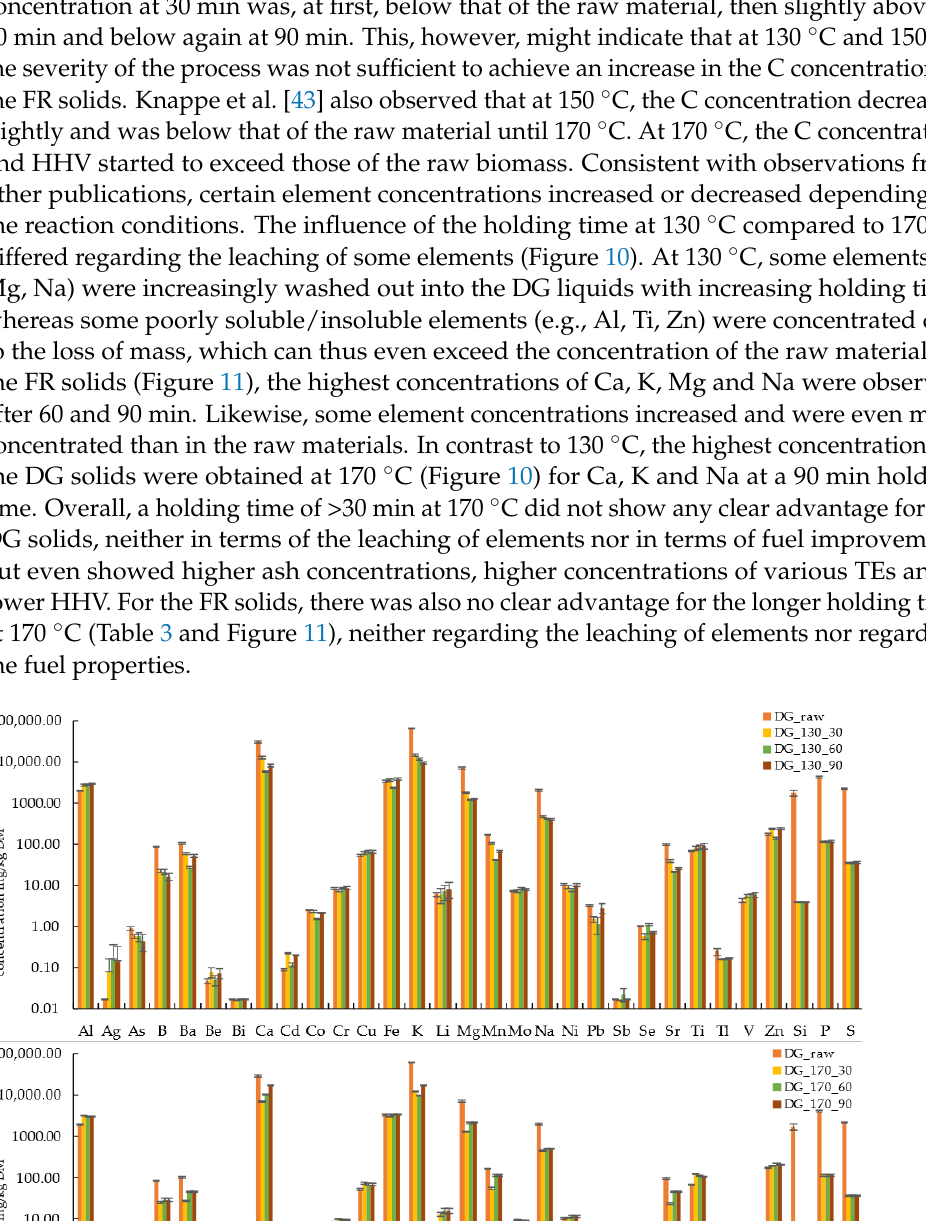
Figure 11. Dry matter (DM) based on mean values ± standard deviations of different elements for raw materials and solids provided by hydrothermal treatment of the forest residue (FR) at 130 and 170 °C with 30, 60 and 90 min holding times. Numerical values can be found in Appendix A. In the DG liquids, the highest counts for compounds 22, 29 and 20 were detected at 130 °C and 30 min (Figure 2). At a 60 min holding time, the number of counts was the